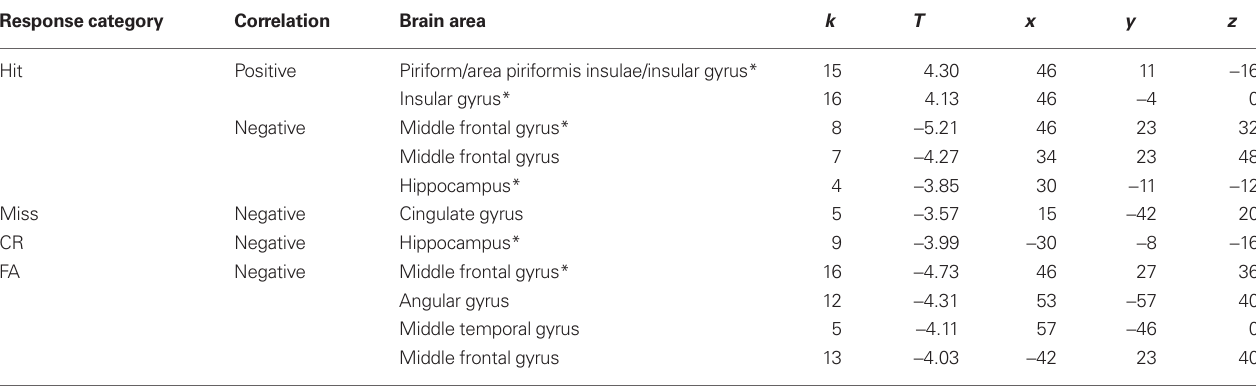
Table 5 | Cerebral areas where activation was positively or negatively correlated with memory scores for Hits, Misses, correct rejections (CR) and false alarms